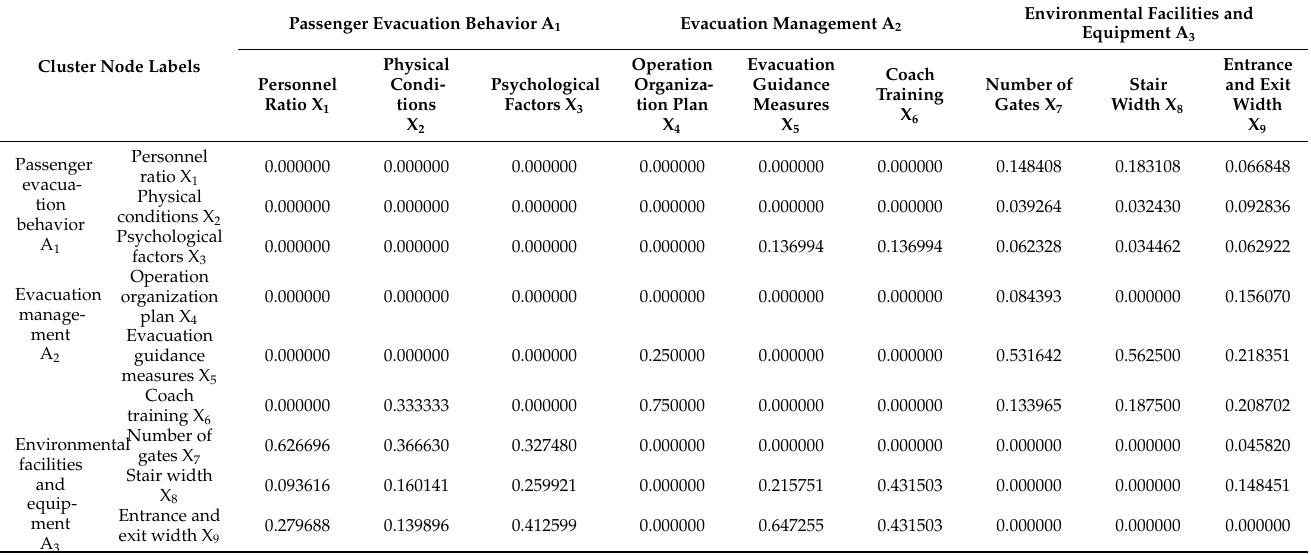
Table 1. The super matrix.